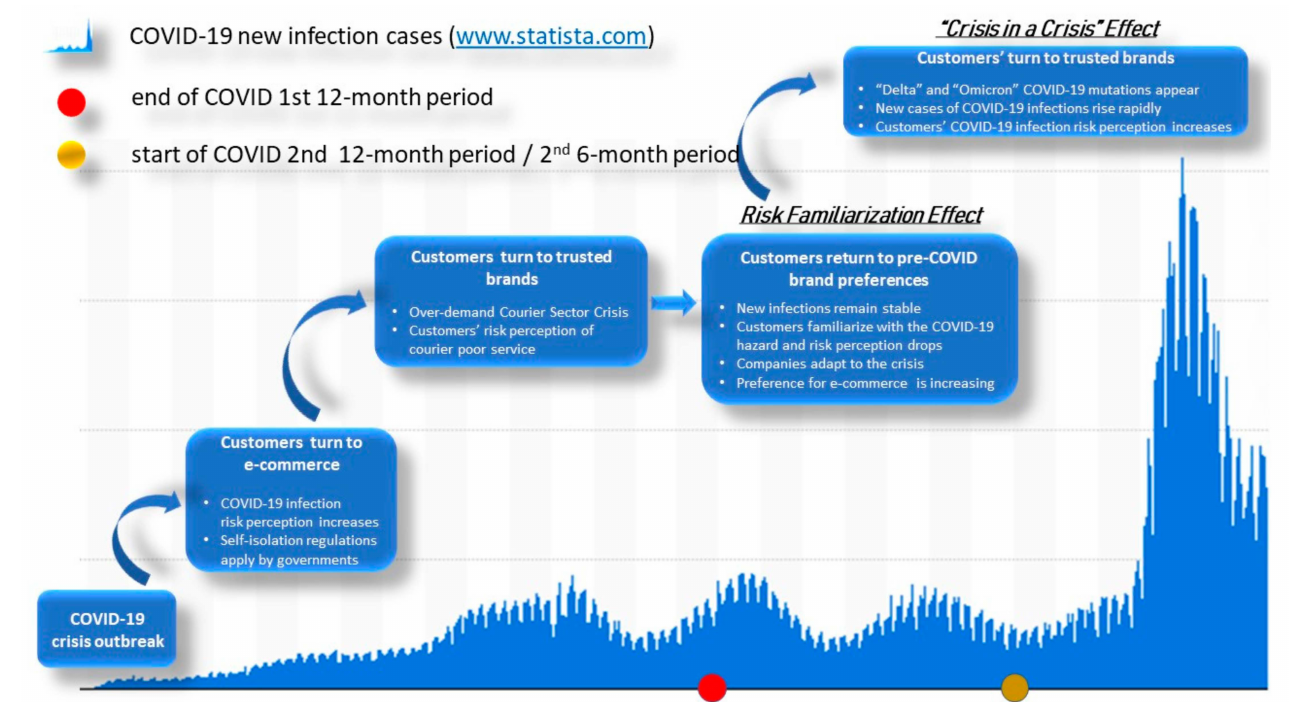
Figure 1. Proposed conceptual